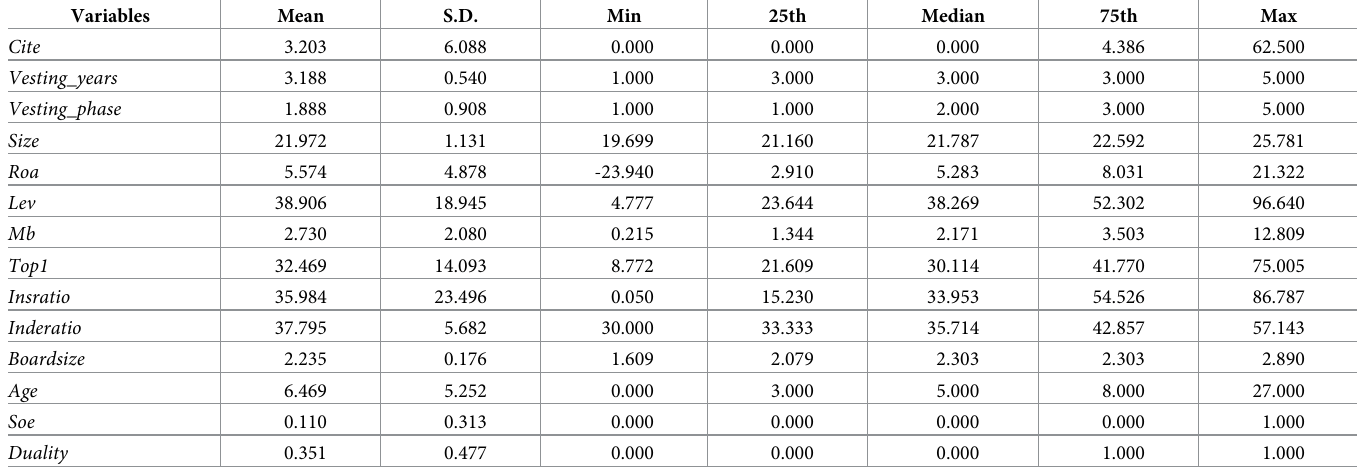
Table 1. Summary